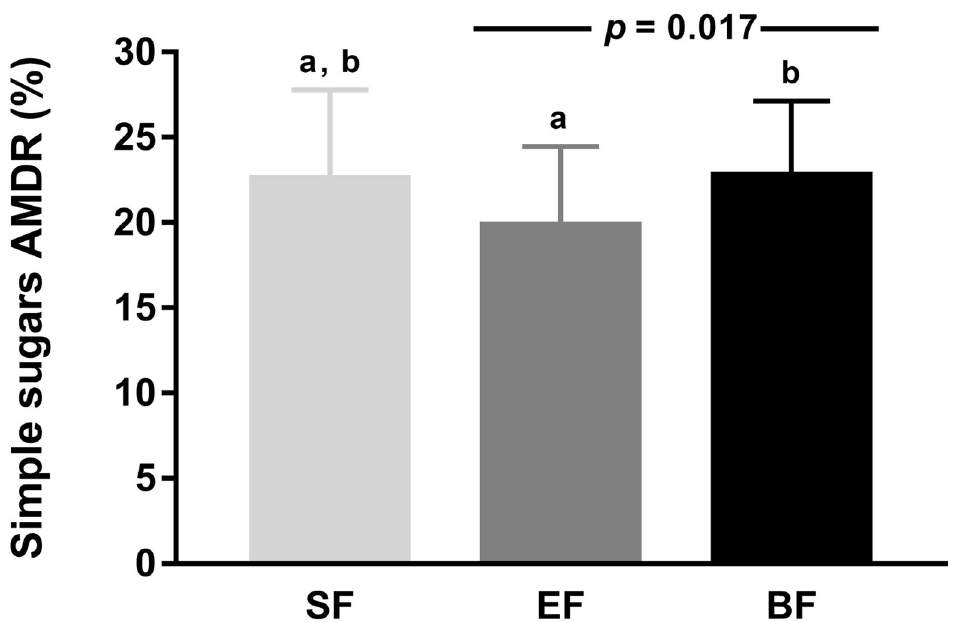
Figure 3. Simple sugars acceptable macronutrient distribution ranges (AMDR) in children by study groups at 6 years old. Data are presented as mean ± SD. Values which do not share the same suffix (ab) are significantly different in a Bonferroni post hoc test. p -value for differences between EF and BF groups. AMDR: acceptable macronutrient distribution ranges; BF: breastfeeding; EF: experimental infant formula; SF: standard infant